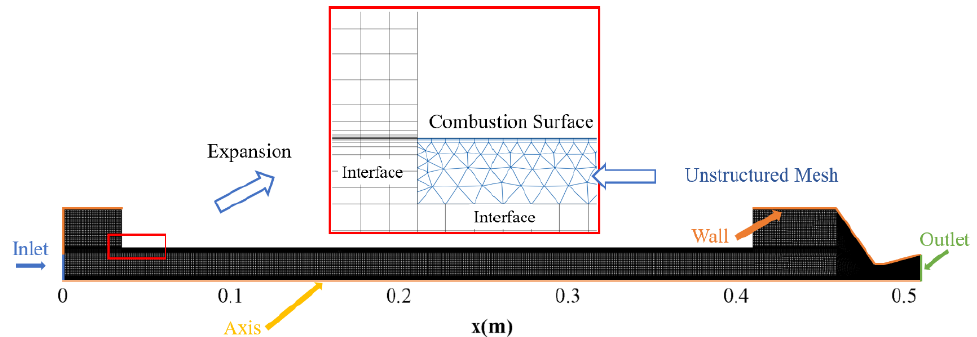
Figure 2. Computational mesh of this HRM. Table 2. Structure sizes of this